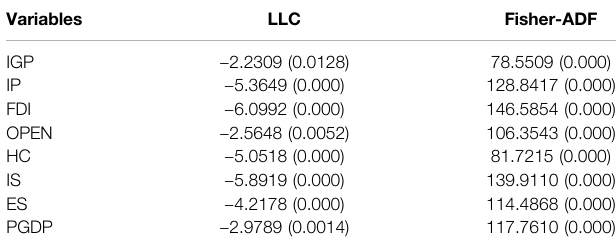
TABLE 2 | Panel unit root